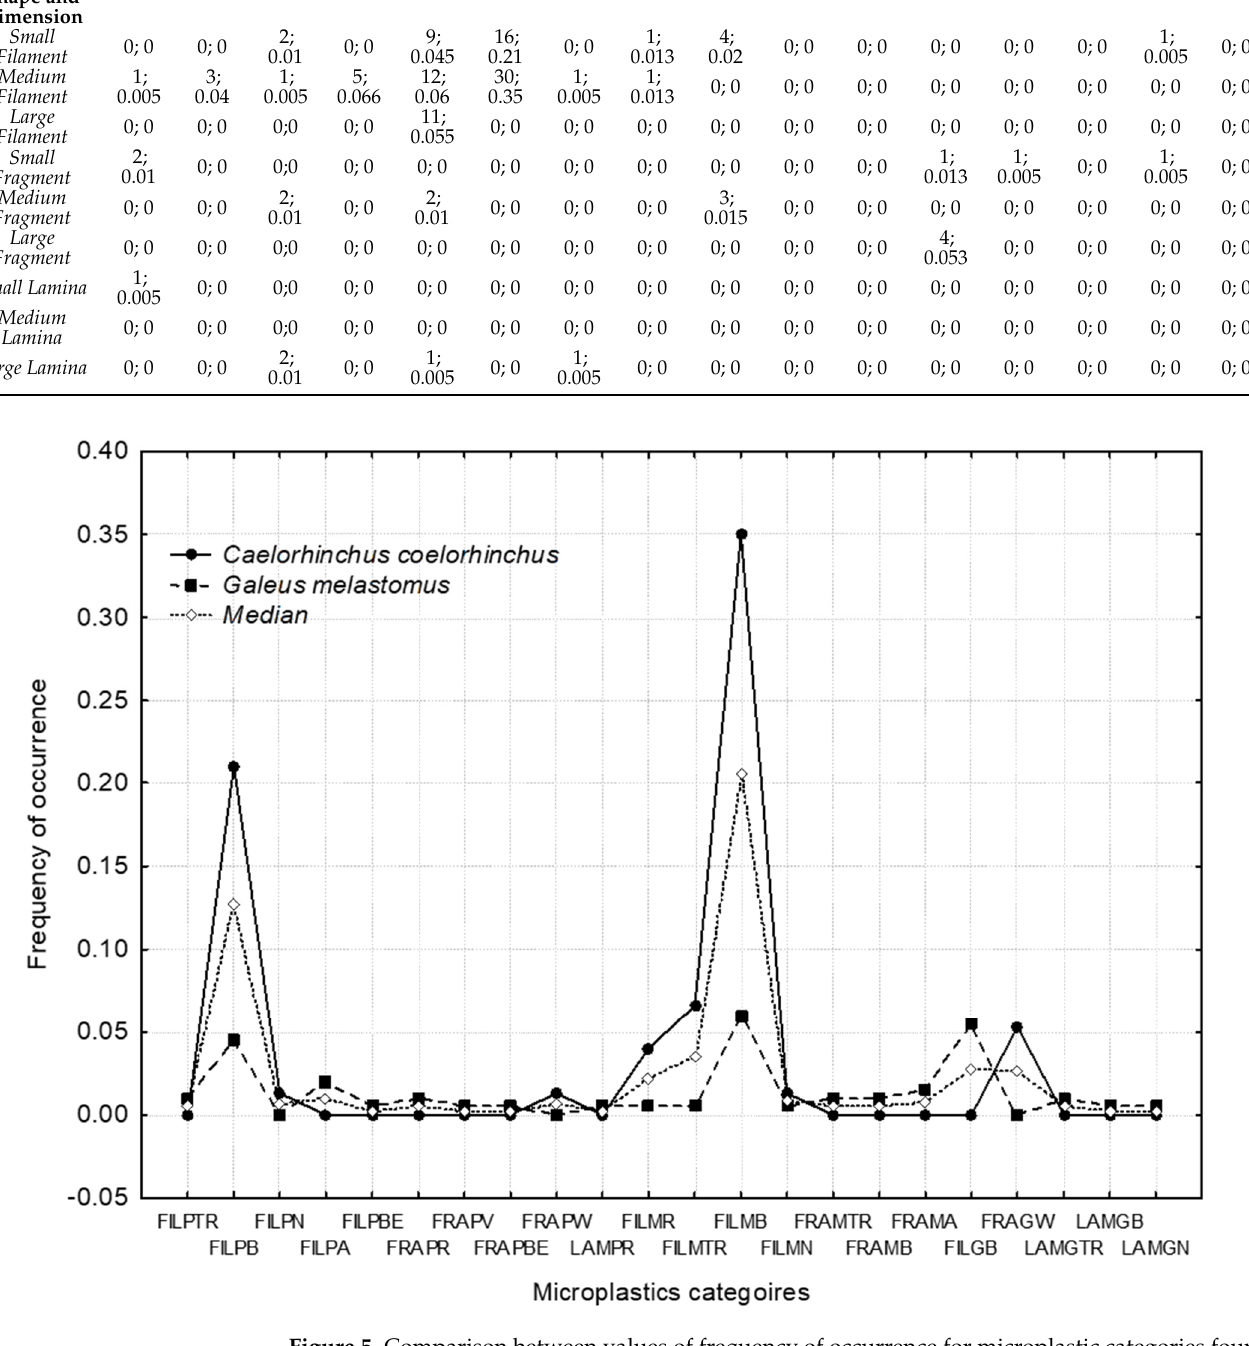
Table 2. Number and corresponding (%) frequency of occurrence (on the left and right, respectively, separated by semicolons) of the different microplastic items found (and potentially present) in the stomachs of two bottom dwelling opportunistic feeder species Galeus melastomus (GM) and Caelorhinchus coelorhinchus (CC) from the bathyal plane of the eastern central Tyrrhenian Sea.